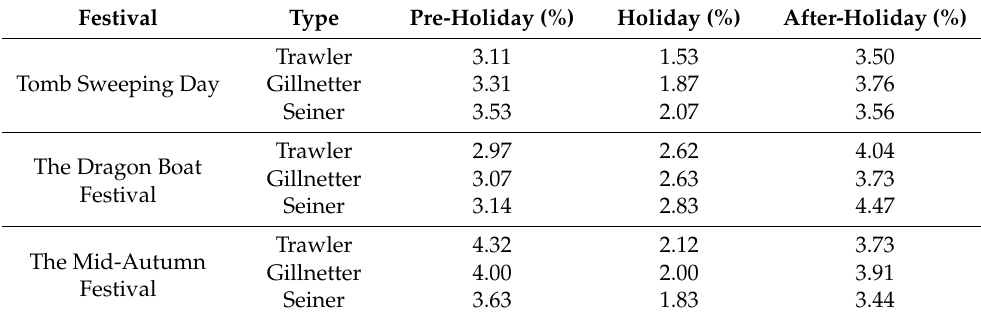
Table 9. Average daily number of Chinese fishing vessels during and around traditional festivals. Festival Type Pre-Holiday (%) Holiday (%) After-Holiday (%) Tomb Sweeping Day